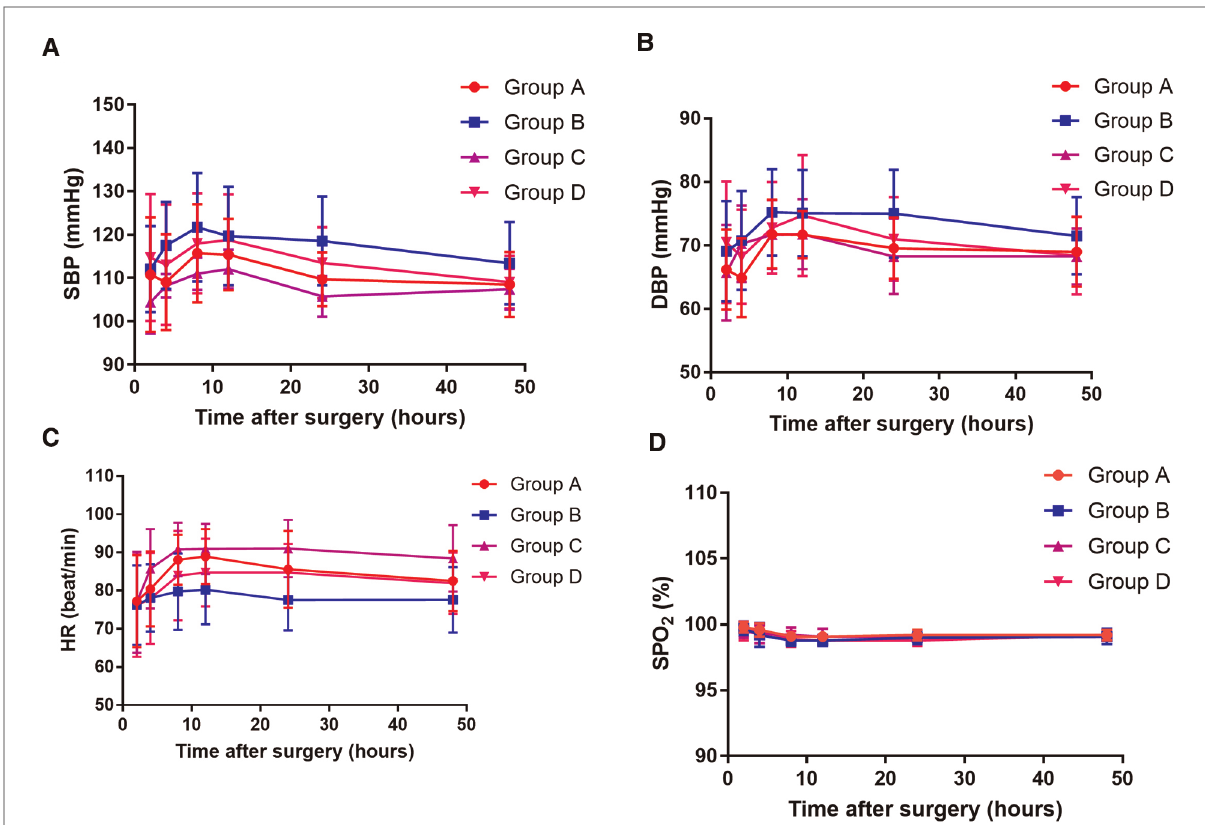
FIGURE 3 The systolic blood pressure (SBP) value ( A ), diastolic blood pressure (DBP) value ( B ), heart rate (HR) value ( C ), and oxygen saturation (SPO 2 ) value ( D ) at 10, 20, 30, 40, and 50 h after surgery among the four groups. Group A: administrated with 2 mg morphine hydrochloride; group B: administrated with 0.25 mg/kg of esketamine; group C: administrated with 0.25 mg/kg of esketamine in combination with 2 mg morphine hydrochloride; and group D: administrated with 0.25 mg/kg of esketamine in combination with 1 mg morphine hydrochloride.